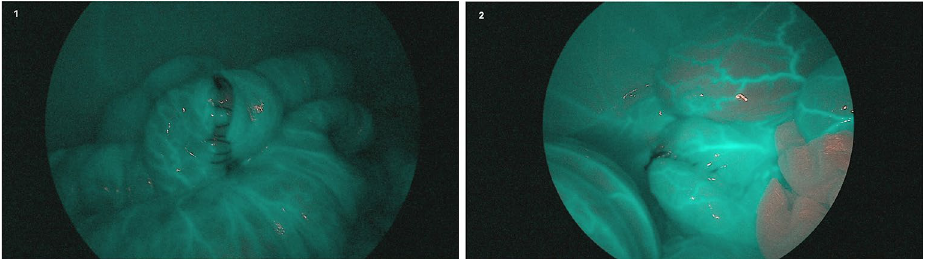
Figure 1. Laparoscopic image in Spectra A + ICG mode of running suture manual end-to-end anastomosis of the right colon (1), without arterial manipulation, and of the left colon (2), without arterial